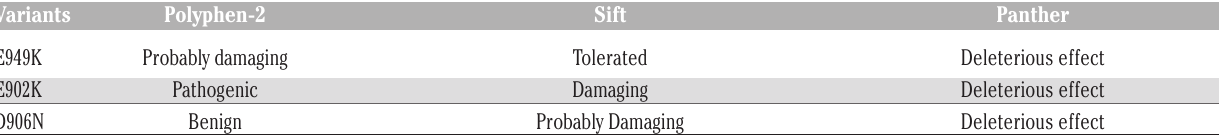
Table 2. In silico analysis of both compound heterozygous mutations in RCM